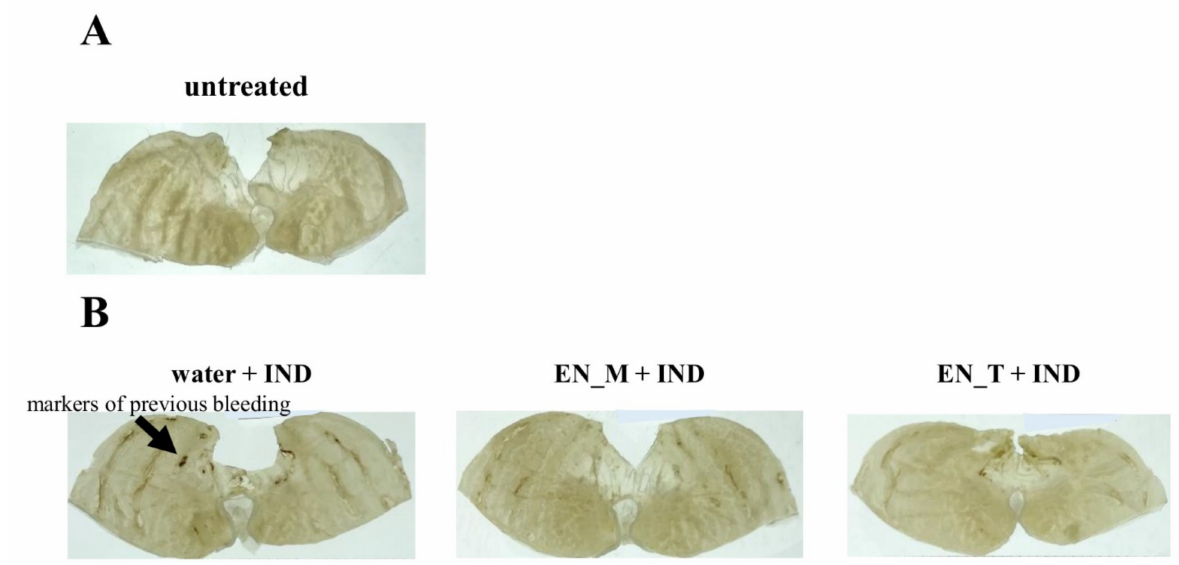
Figure 2. Effects of EN_M and EN_T on IND-induced gastric lesions. Figures show representative photographs of stomachs taken after fixation for 21 h in 10% neutral-buffered formalin following removal 6 h after subcutaneous IND (20 mg/kg) administration. ( A ) Untreated group; ( B ) group treated with 25 mL/kg of purified water, EN_M, or EN_T orally 30 min before subcutaneous IND administration.